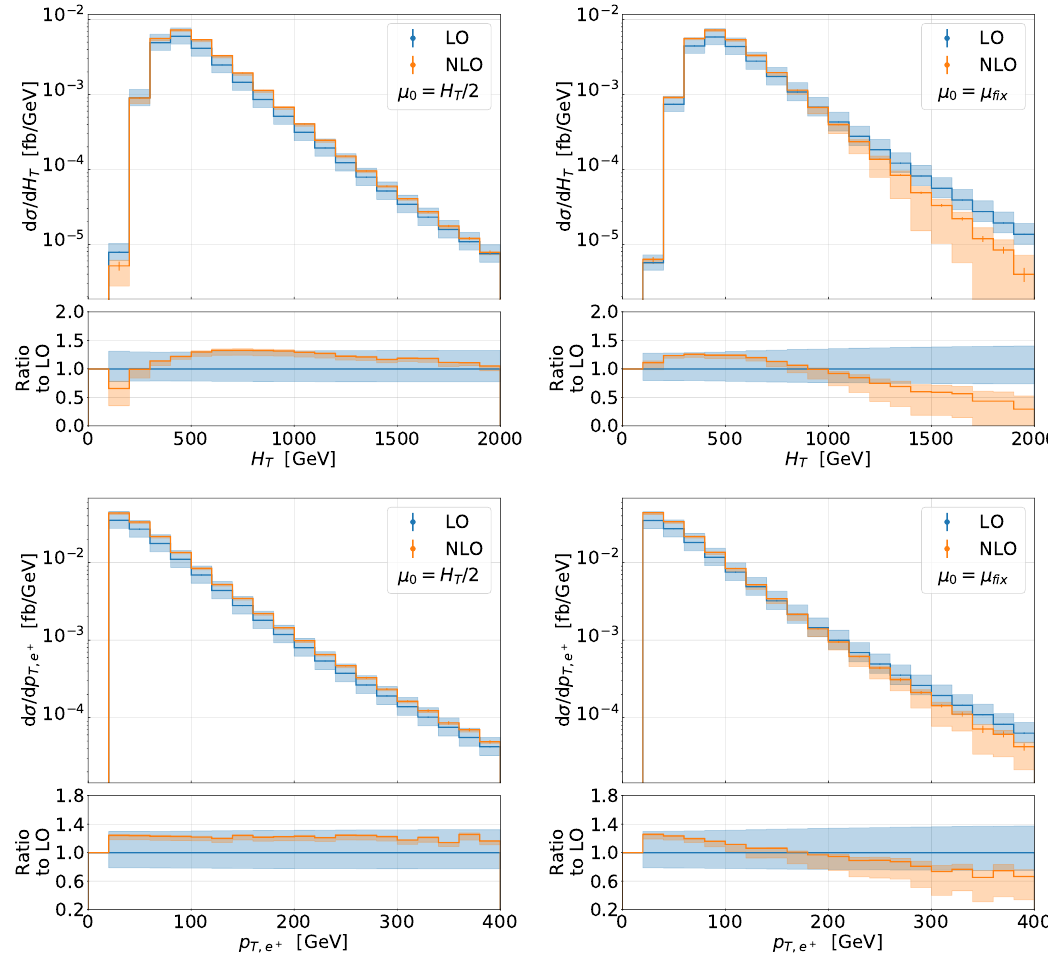
Figure 8 . Differential distributions at LO and NLO QCD with the corresponding uncertainty bands for the observables H T and p for the pp → e + ν e µ − ¯ ν µ b ¯ b H process at the LHC with T,e + √ s = 13 TeV. Results are presented for µ 0 = H T / 2 and µ 0 = µ fix . The NNPDF3.1 PDF set is employed. Also given are Monte Carlo integration errors. The lower panels display the differential K